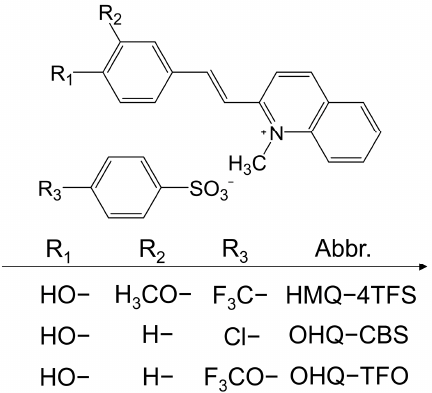
Figure 4. Chemical structures of quinolinium-based compounds with a halogen-free cation.